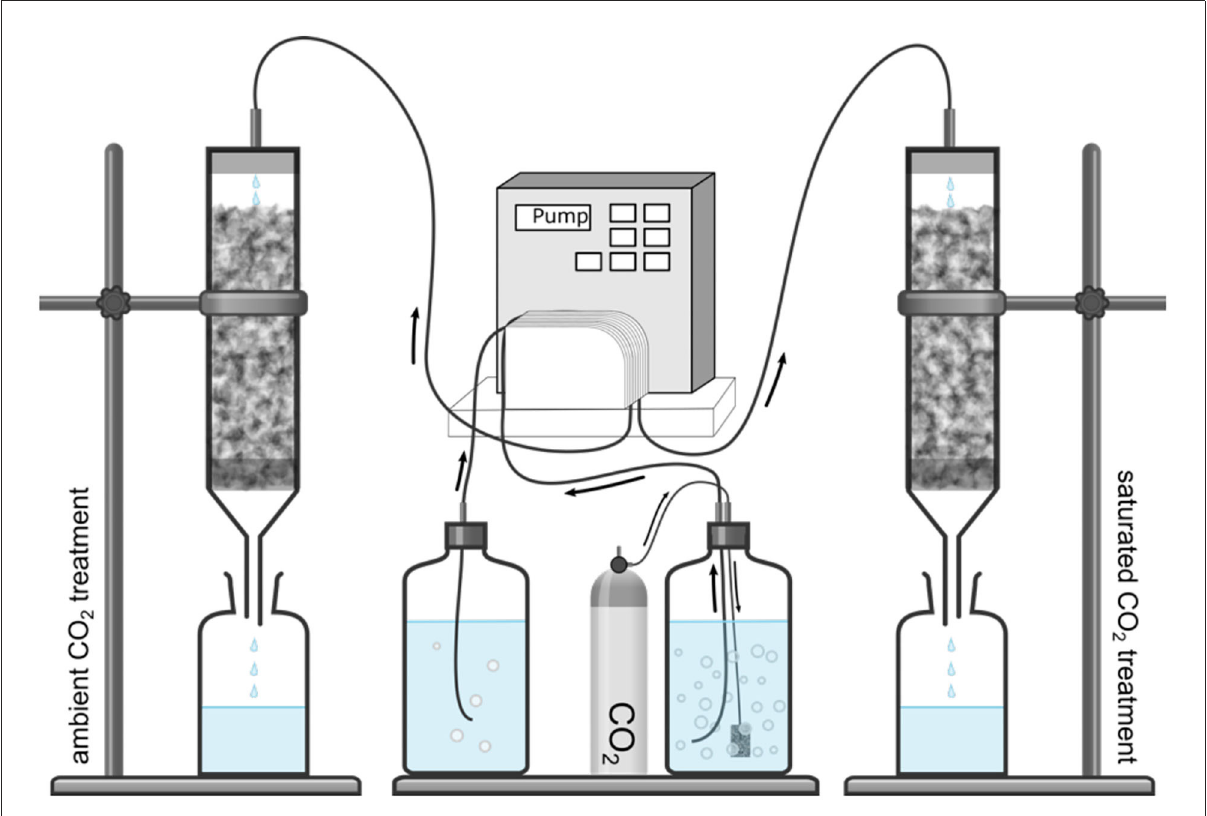
FIGURE2 Experimental setup showing the semi-automated watering system for the CO 2 column